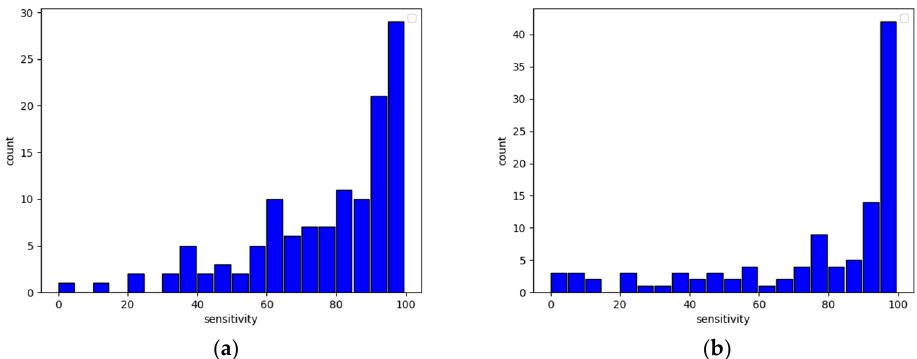
Figure 10. User sensitivity histogram with undamaged data ( a ) and data without accelerometer axis z ( b ).